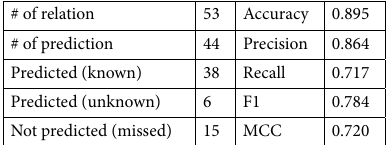
Table 6. Evaluation on <Flavor compound-Food> relation